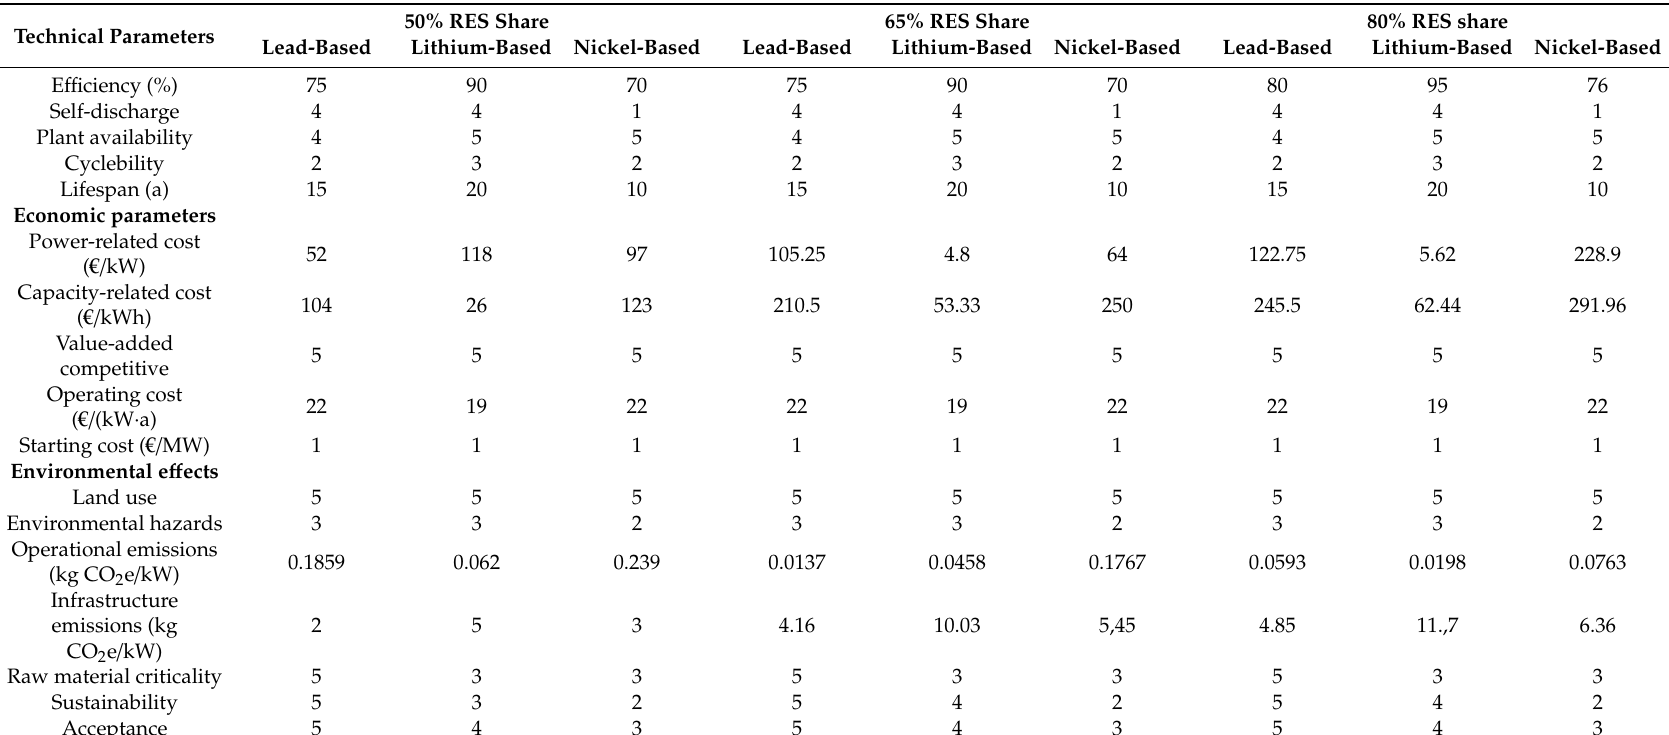
Table A7. AHP input data for short-term EESS system. The data used stems from